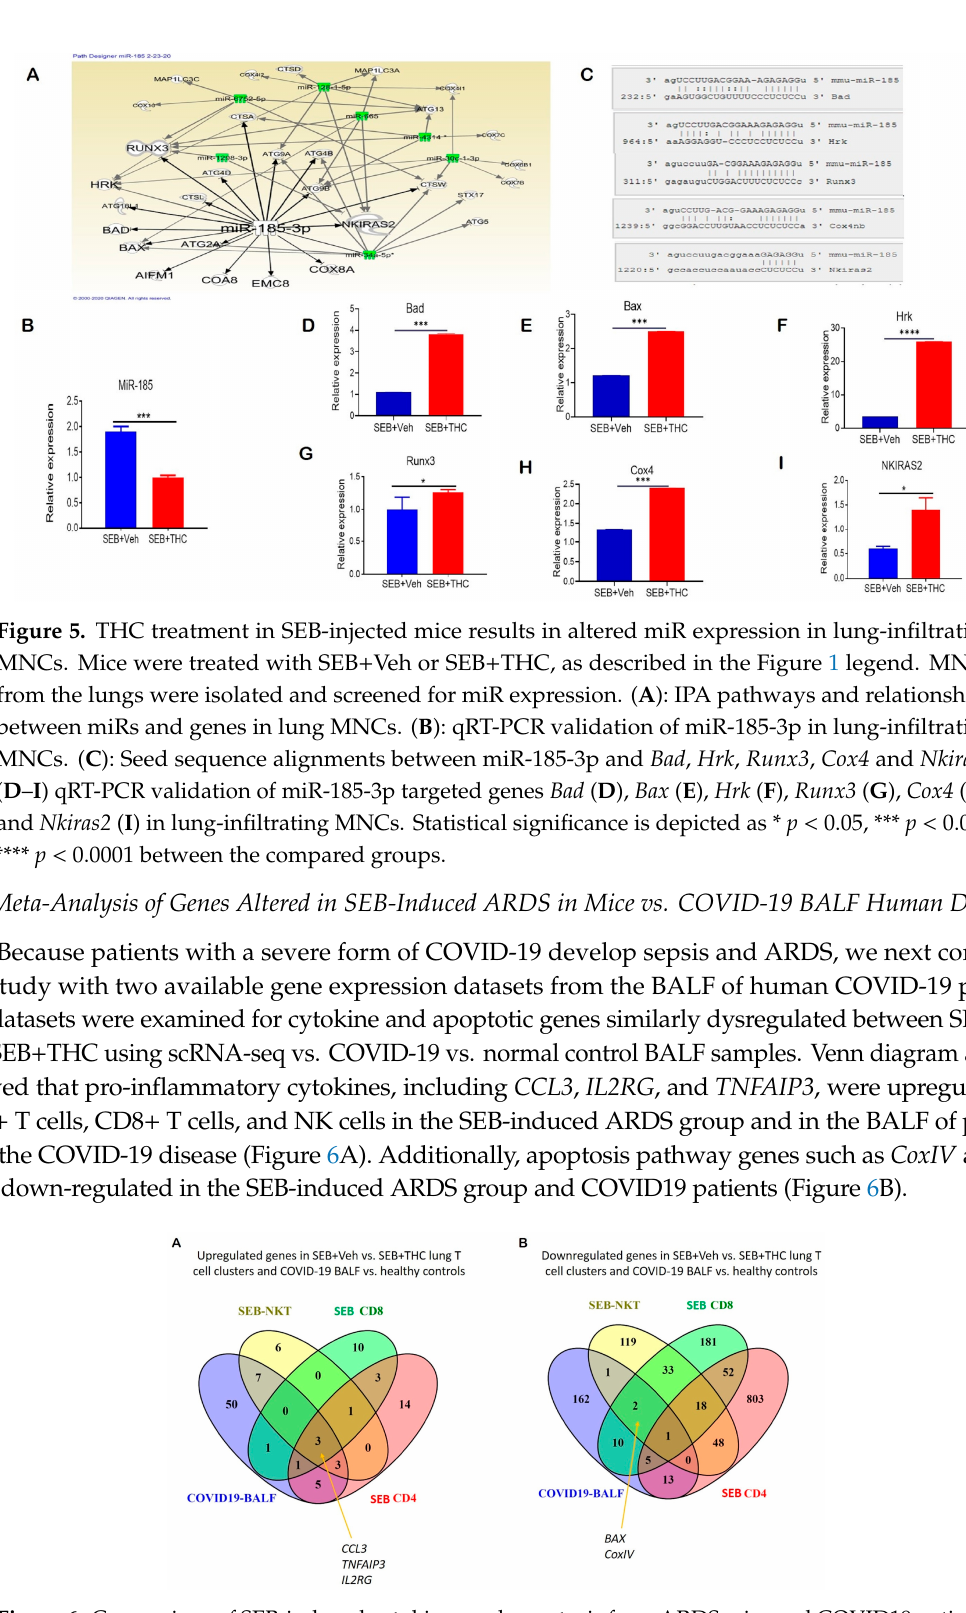
Figure 6. Comparison of SEB-induced cytokines and apoptosis from ARDS mice and COVID19 patients. ( A ): Venn diagram was used in the display of up-regulated genes related to proinflammatory cytokines from SEB-induced ARDS mice and COVID19 BALF patients. ( B ): Venn diagram was used for displaying common down-regulated genes related to the apoptosis pathway from SEB-induced ARDS mice and COVID19 BALF patients.